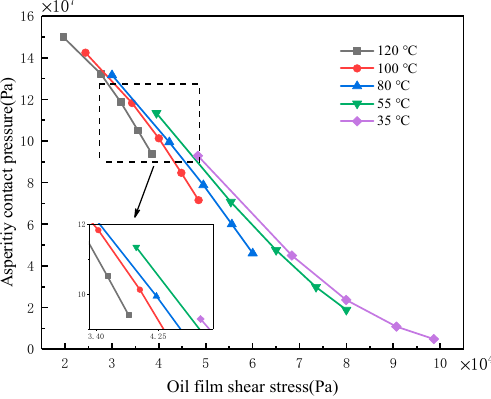
Figure 7. Relationship between asperity contact pressure and shear stress at different temperatures.